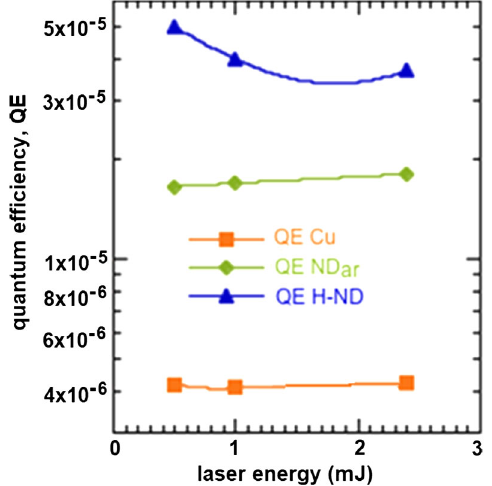
FIG. 6. Quantum efficiency (QE) of the Cu, ND based photocathodes vs laser energy. FIG. 7. Temporal response for the three